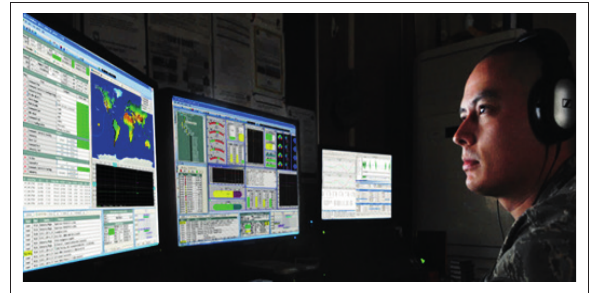
figure 2. Interaction of operators with the CubeSat through MCC (Braxton Tech